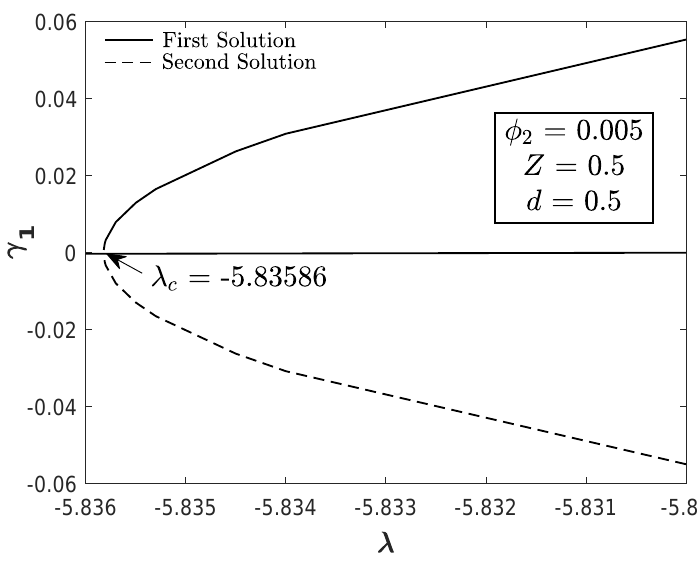
Figure 11. γ 1 of first and second solutions towards λ c